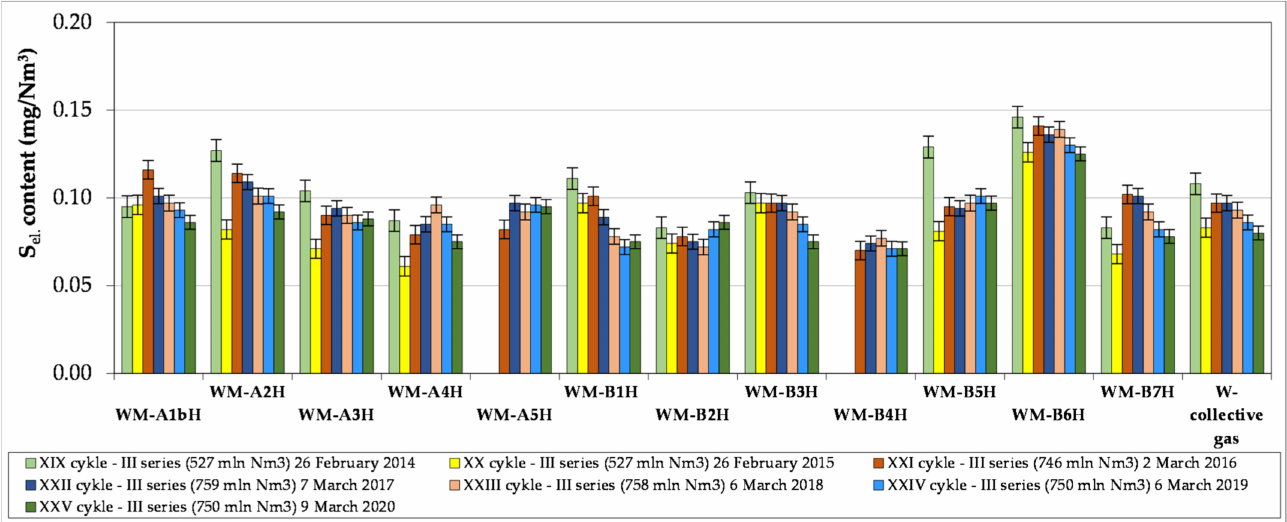
Figure 9. A comparison of the organic sulphur compounds converted to S el. content in the gas from the operational horizontal wells in the A and B clusters of the Wierzchowice Underground Gas Storage facility (series III), cycles